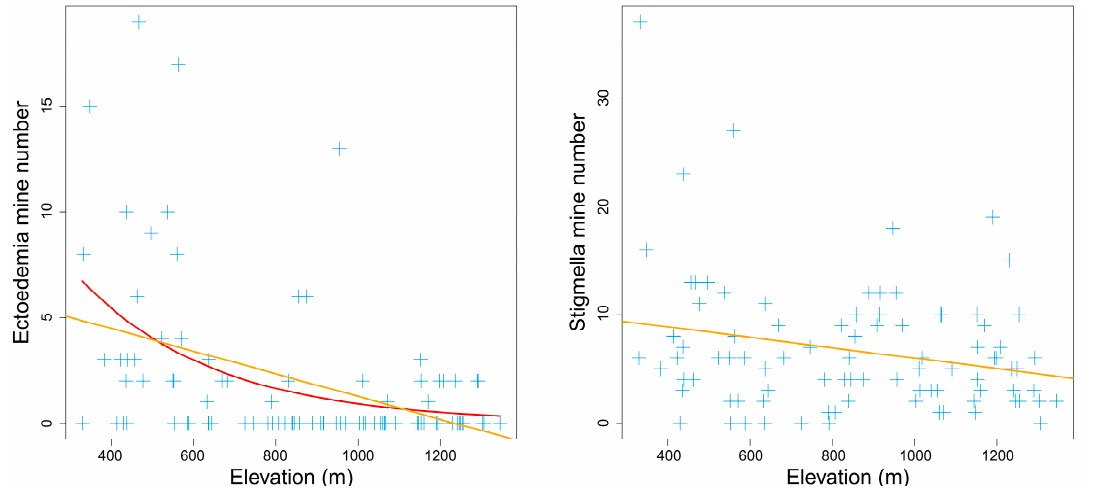
Figure 2. Elevation decreasing pattern of mine numbers on Quercus variabilis Blume. The orange line was fitted with the piecewise linear model, while the red line was fitted with the nonlinear quadratic model.